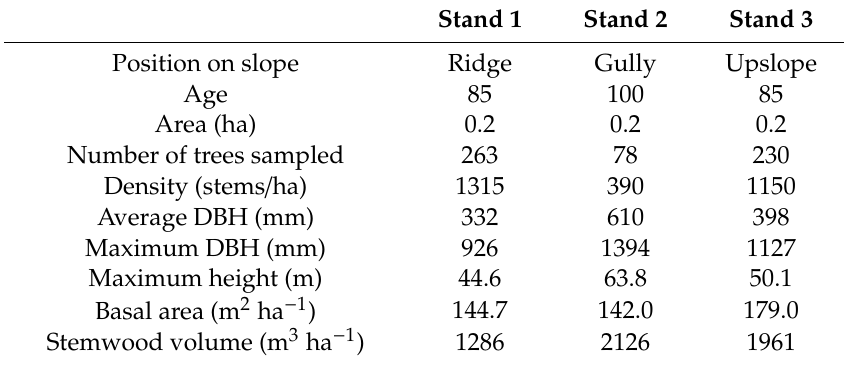
Table 2. Summary data for 0.2 ha plot in three even-aged stands at age 85–100 years in the Jackson Demonstration State